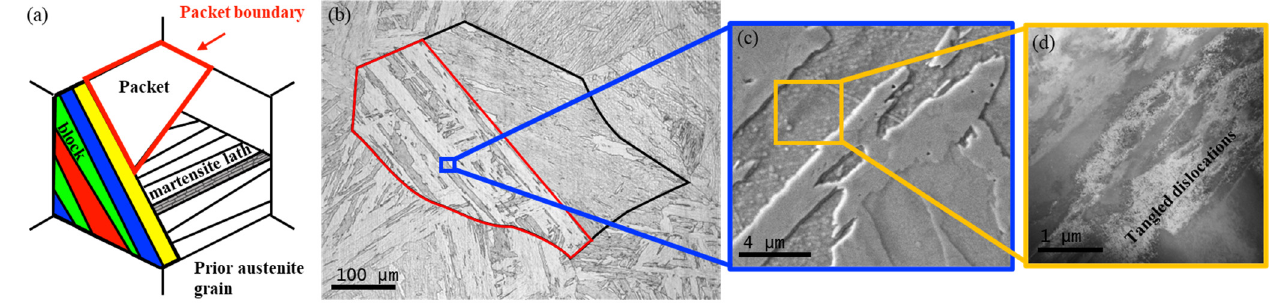
Figure 2. ( a ) Schematic illustration, ( b ) MO image, ( c ) SEM(SE) image and ( d ) STEM image of martensite microstructure of maraging 13Ni15Co10Mo annealed at 900 °C for 1 h and cooled in air. OM and SEM samples were etched with Vilella’s reagent.